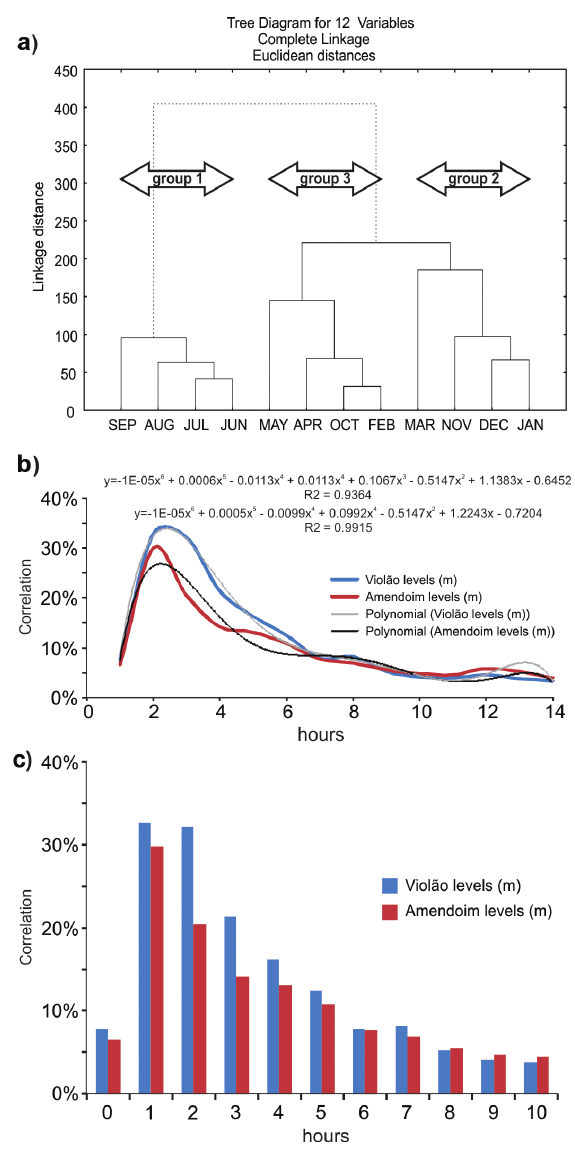
Figure 3 - a) Cluster analysis of the rainfall data of 2013-2014: the dry season extend from June to September (group 1), the rainy season from October to May (group 2 and 3); Pearson’s r correlation test between the total rainfall and the lake level in the following hours: b) Line plot with polynomial regression; c) Bar